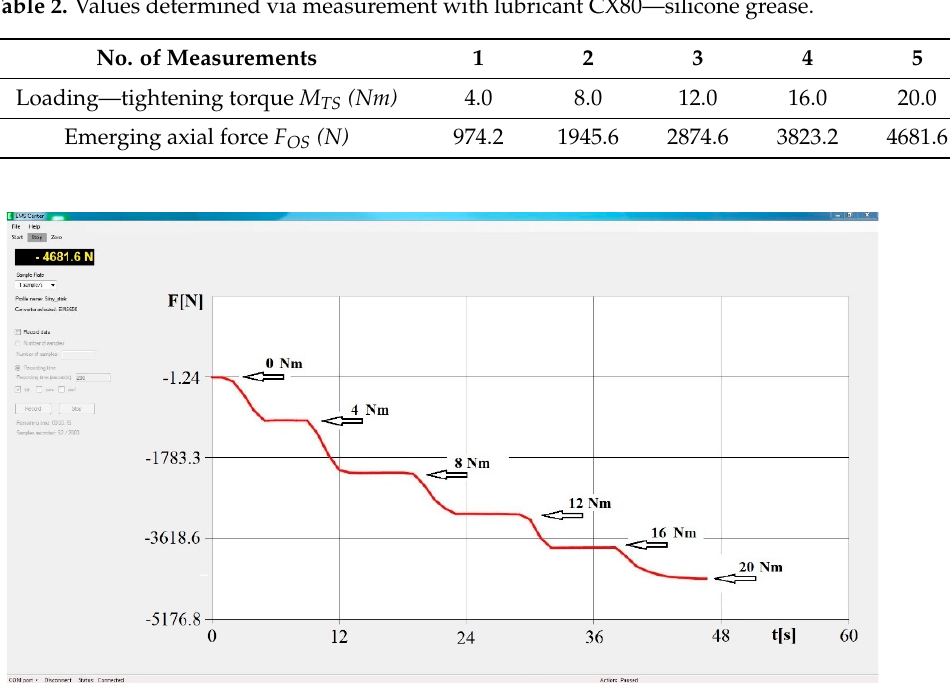
Figure 9. Dependence of the emerging force F OS on time.